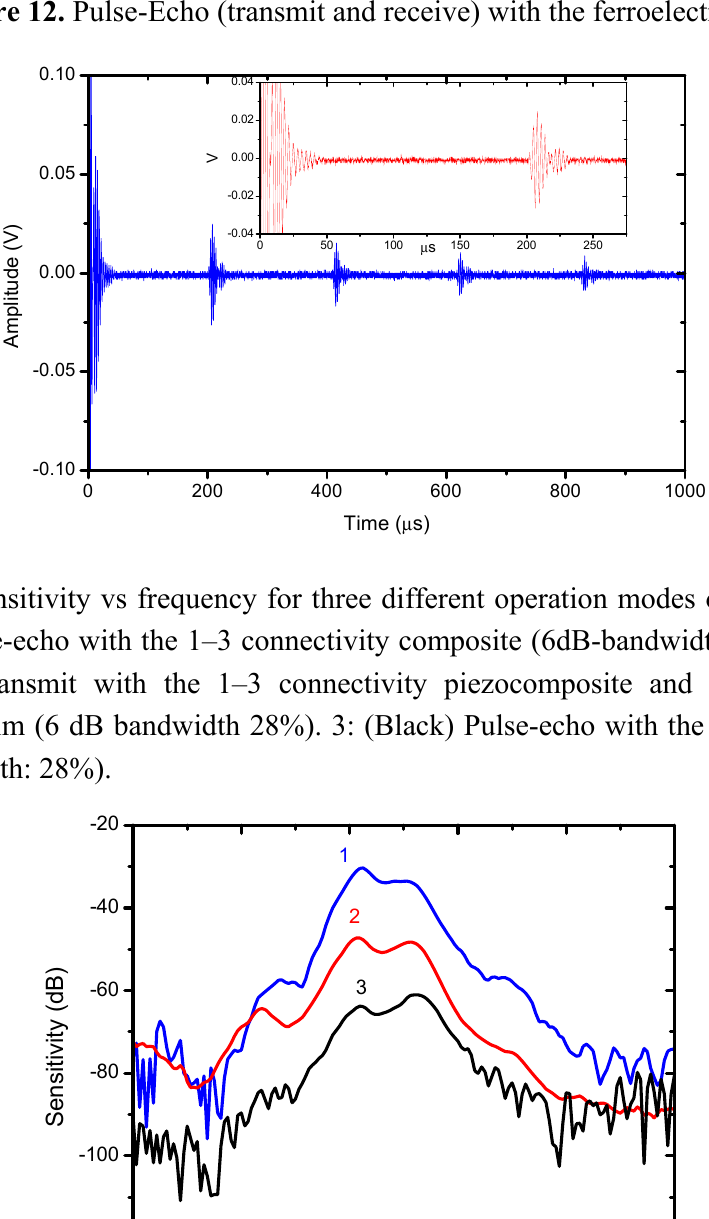
Figure 12. Pulse-Echo (transmit and receive) with the ferroelectret film.